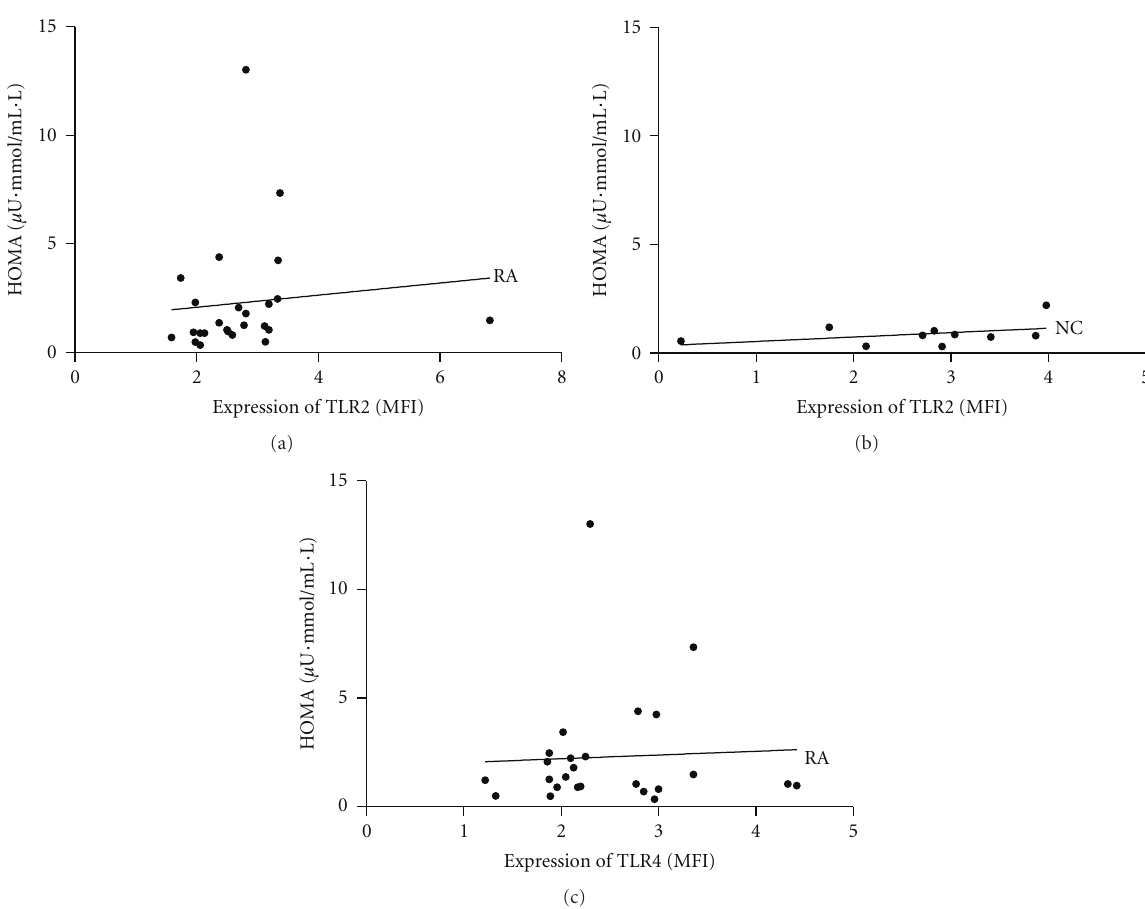
Figure 4: Relationship between HOMA index and fold increase of TLR2 or TLR4 expression (MFI) in monocytes after stimulation with peptidoglycan or lipopolysaccharide in RA patients and normal controls (NC). (a) HOMA index significantly correlated with TLR2 expression after stimulation with 10 μ g/mL of peptidoglycan in RA patients ( r = 0 . 441, P = 0 . 027); (b) no significant correlation between HOMA index and TLR2 expression in normal controls ( r = 0 . 249, P = 0 . 492); (c) no significant correlation between HOMA index and TLR4 expression after stimulation with 10 ng/mL of lipopolysaccharide in RA patients ( r = 0 . 057, P = 0 . 787).